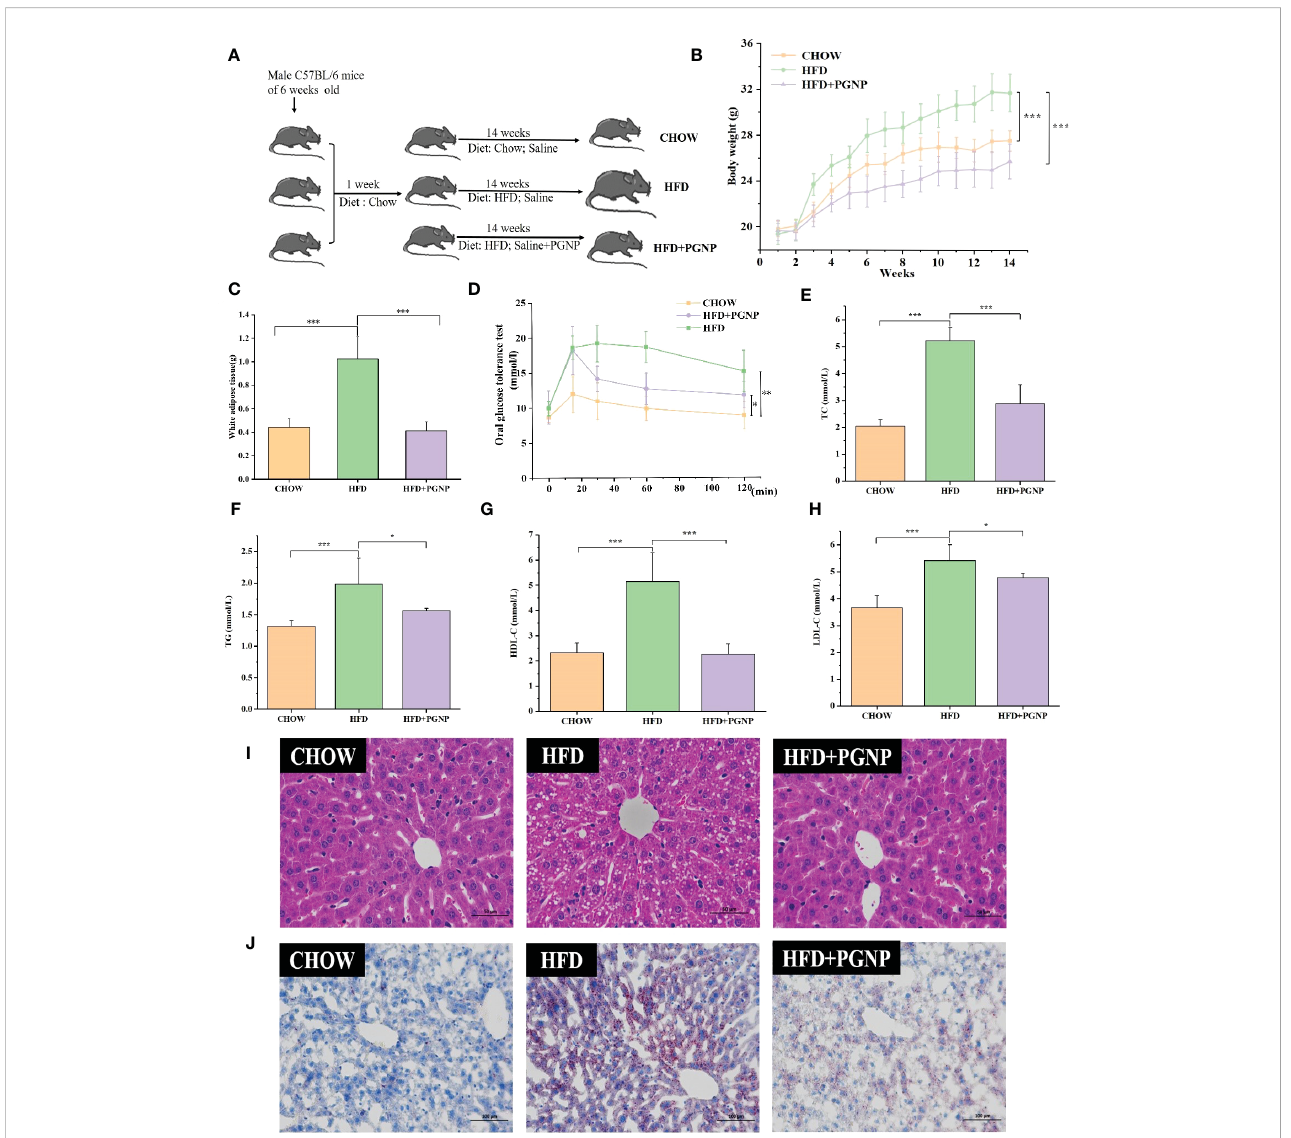
FIGURE 2 Effects of PGNP on body weight gain and fat accumulation in HFD-fed mice. Schematic representation of animal experiment process (A) Body weight, two-way anova coupled with Turkey ’ s multiple-comparison post hoc test was used, and P <0.001 was determined and shown at week 14 (B) Epididymal white adipose tissue (C) Oral glucose tolerance test (OGTT) (D) TC levels in serum (E) TG levels in serum (F) HDL-C levels in serum (G) ; LDL-C levels in serum (H) Liver tissue sections histologically stained with H&E and Oil Red O (I, J) *** P < 0.001, ** P < 0.01, * P <